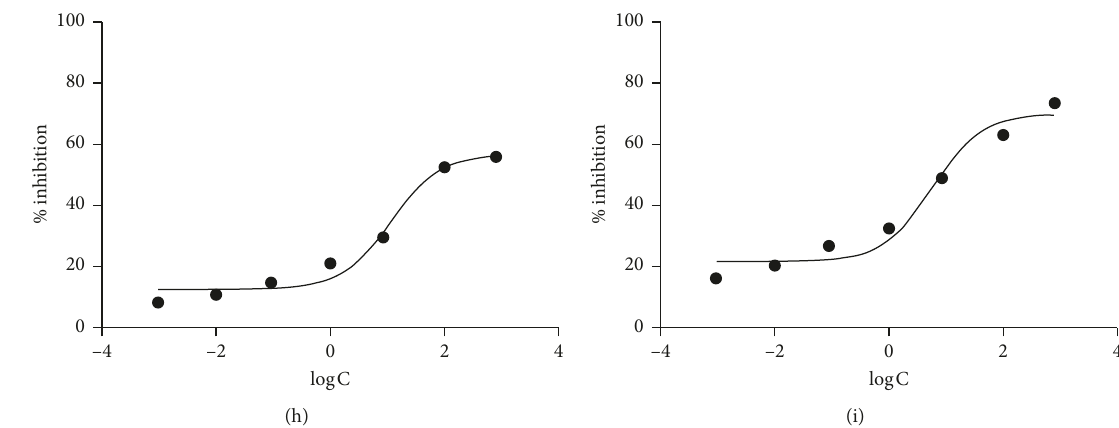
Figure 1: IC 50 ( μ M) of the selected compounds ( 4a , 4b , 4c , 4d , 4e , 4f , 4g , and 4i ) and control drugs against MAO-A enzyme. (a) Moclobemide (6.06 μ M); (b) 4a (7.06 μ M); (c) 4b (6.56 μ M); (d) 4c (6.78 μ M); (e) 4d (10.98 μ M); (f) 4e (13.08 μ M); (g) 4f (12.41 μ M); (h) 4g (13.45 μ M); (i) 4i (7.09 μ M).